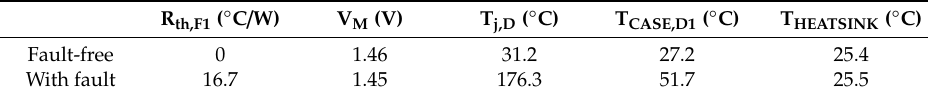
Figure 9. In-circuit thermal test for diode device. Table 2. In-circuit diode results.